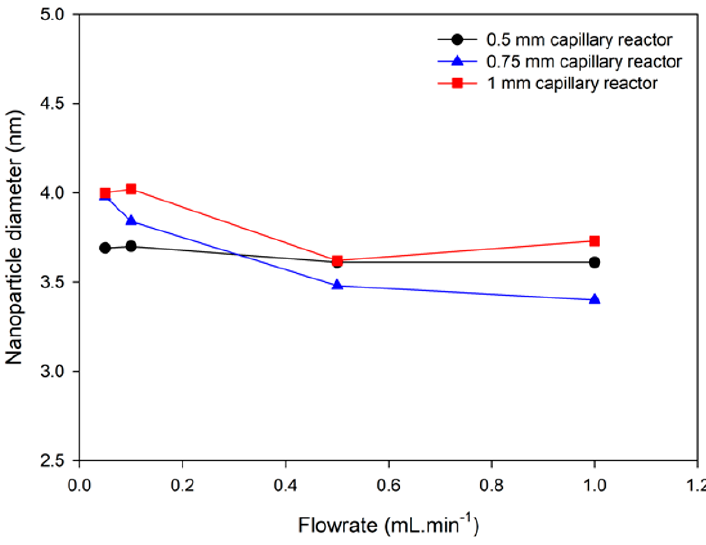
Figure 7. Average diameter of VSION as a function of flowrate in capillary reactors with di ff erent internal diameters.